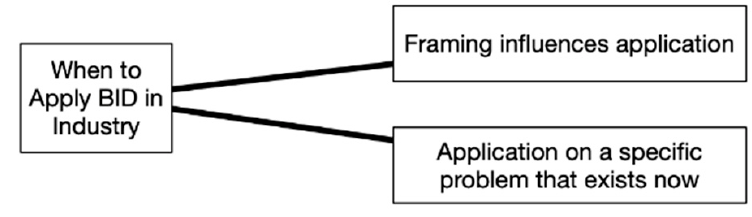
Figure 8. When to apply BID in industry discussion themes.